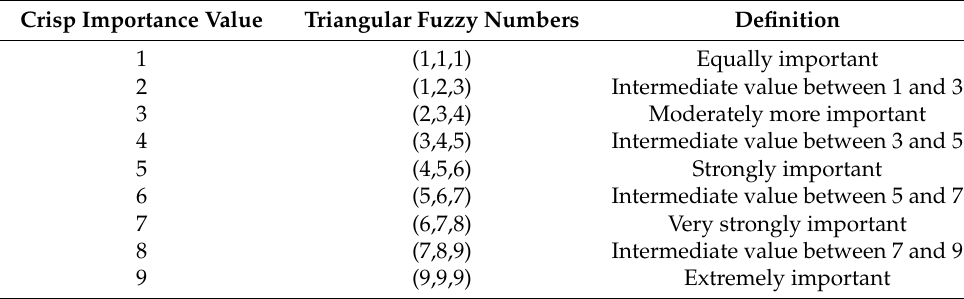
Table 4. The scale of fuzzy AHP pairwise comparison